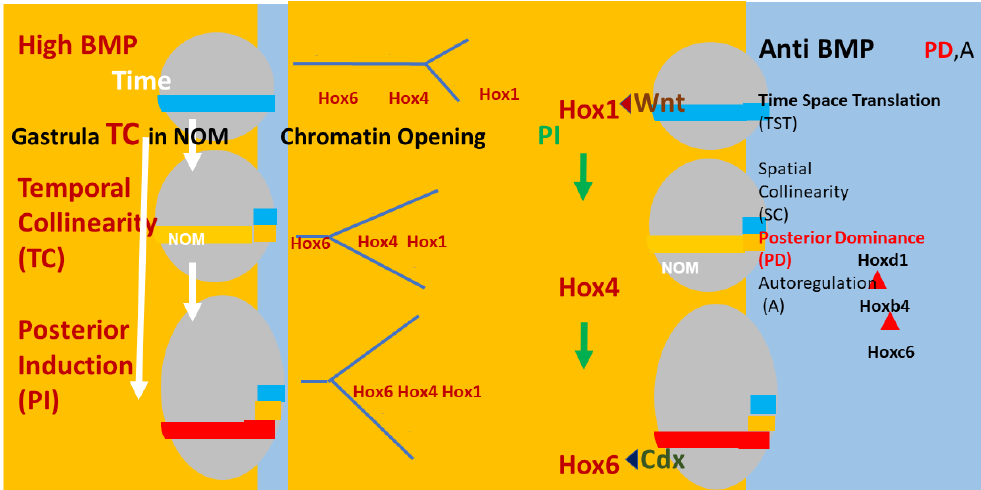
Figure 2. Timing, Axial patterning, and Time Space Translation. Left and right: (Xenopus) embryos (grey ovals) at 3 sequential stages in gastrulation. The non-organiser mesoderm (NOM) (horizontal coloured stripe) runs from ventral to near dorsal. I show some of the successive stages of temporally collinear Hox expression. First, blue stripe (Hoxd1 is the most posterior Hox gene expressed). Then, yellow stripe (Hoxb4 is the most posterior Hox gene expressed). Then, red stripe (Hoxc6 is the most posterior Hox gene expressed). These are three stages in the first part of the NOM temporally collinear (TC) Hox sequence. The yellow background shows that TC happens in the availability of a high BMP concentration, which is available in the ventrolateral part (V) of the embryo (as shown). Under these conditions, Collinear opening of chromatin and the Hox-Hox interaction posterior induction (PI) [36–40], which is necessary for TC, also occur as do Wnt and Cdx inputs into Hox1 genes and Hoxc6, respectively [41]. A thin segment at the right side of the embryo has a blue background (shown in detail for the embryos at the right side of the figure). This represents anti-BMP, which is available in the dorsal side of the embryo (D). Under these conditions, successive blocks of cells are frozen at each successive Hox code and these blocks stack up from early anterior to late posterior to make the A–P axis. This process involves making mesodermal and neural layers of spatially collinear tissue (separation not shown). It involves two late Hox–Hox interactions, Posterior Dominance, whereby posterior Hox genes inhibit function of and repress more anterior Hox genes and Autoregulation, whereby mesodermal Hox expression is copied over non cells autonomously from mesodermal to neural tissue [39,42].